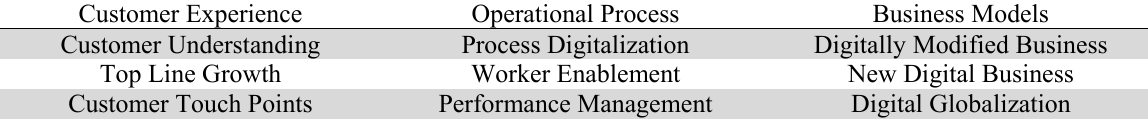
A Part of Building Blocks of the Digital Transformation Source: (Westerman et al. 2011)